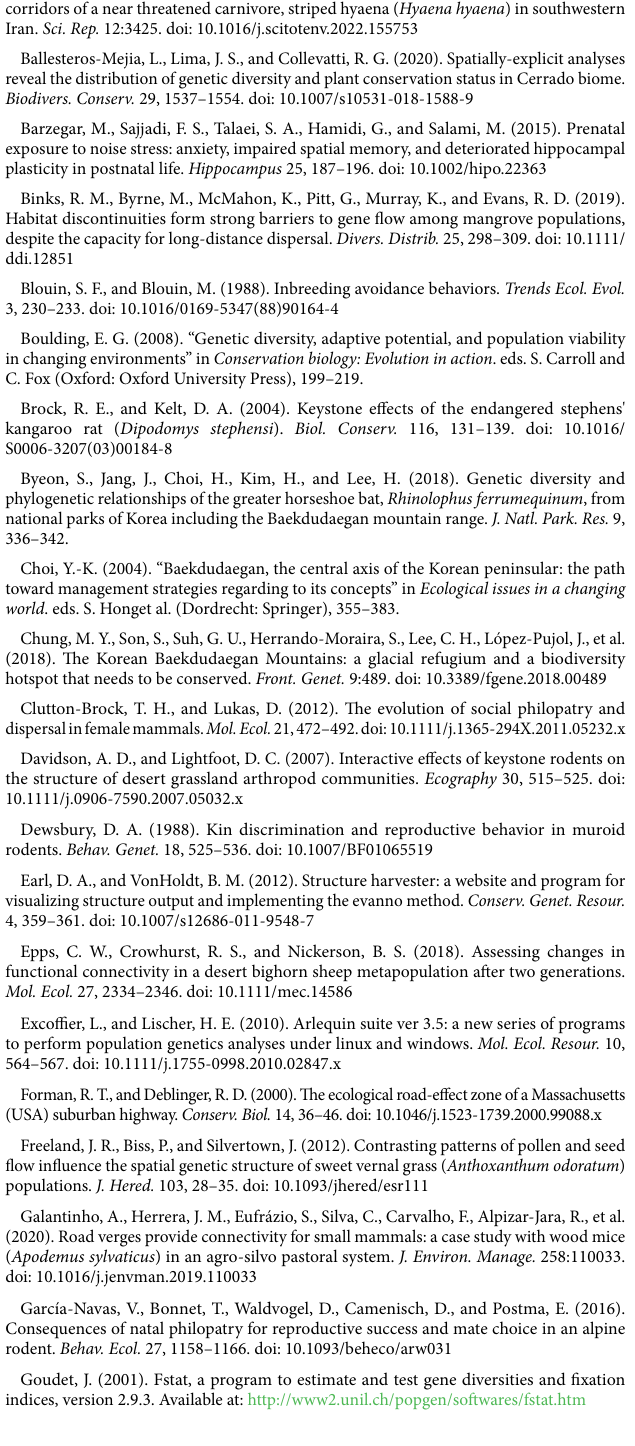
SUPPLEMENTARY FIGURE S1 Phylogenetic relationships based on mtDNA cyt b gene of Apodemus agrarius from Asia and Europe, including South Korea (the mainland, Jeju Island), Russia,